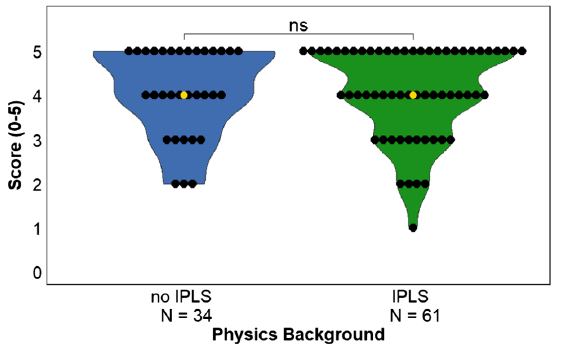
FIG. 5. Total calculation rubric scores for non-IPLS students (blue envelope around black dots) and IPLS students (green envelope around black dots). Each student ’ s score is represented by a black dot, and the median score is represented by a yellow dot; “ ns ” (not significant) means p > 0 . 05